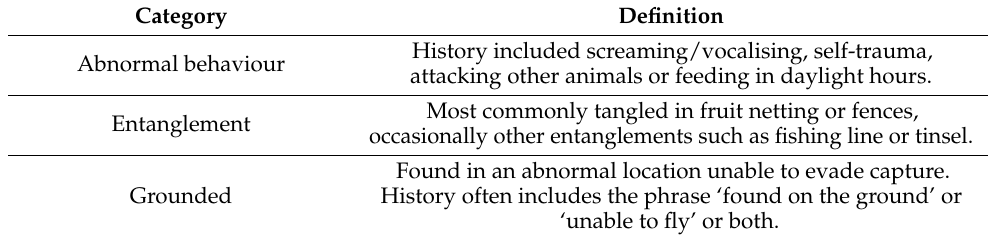
Table 2. Category definitions for circumstances